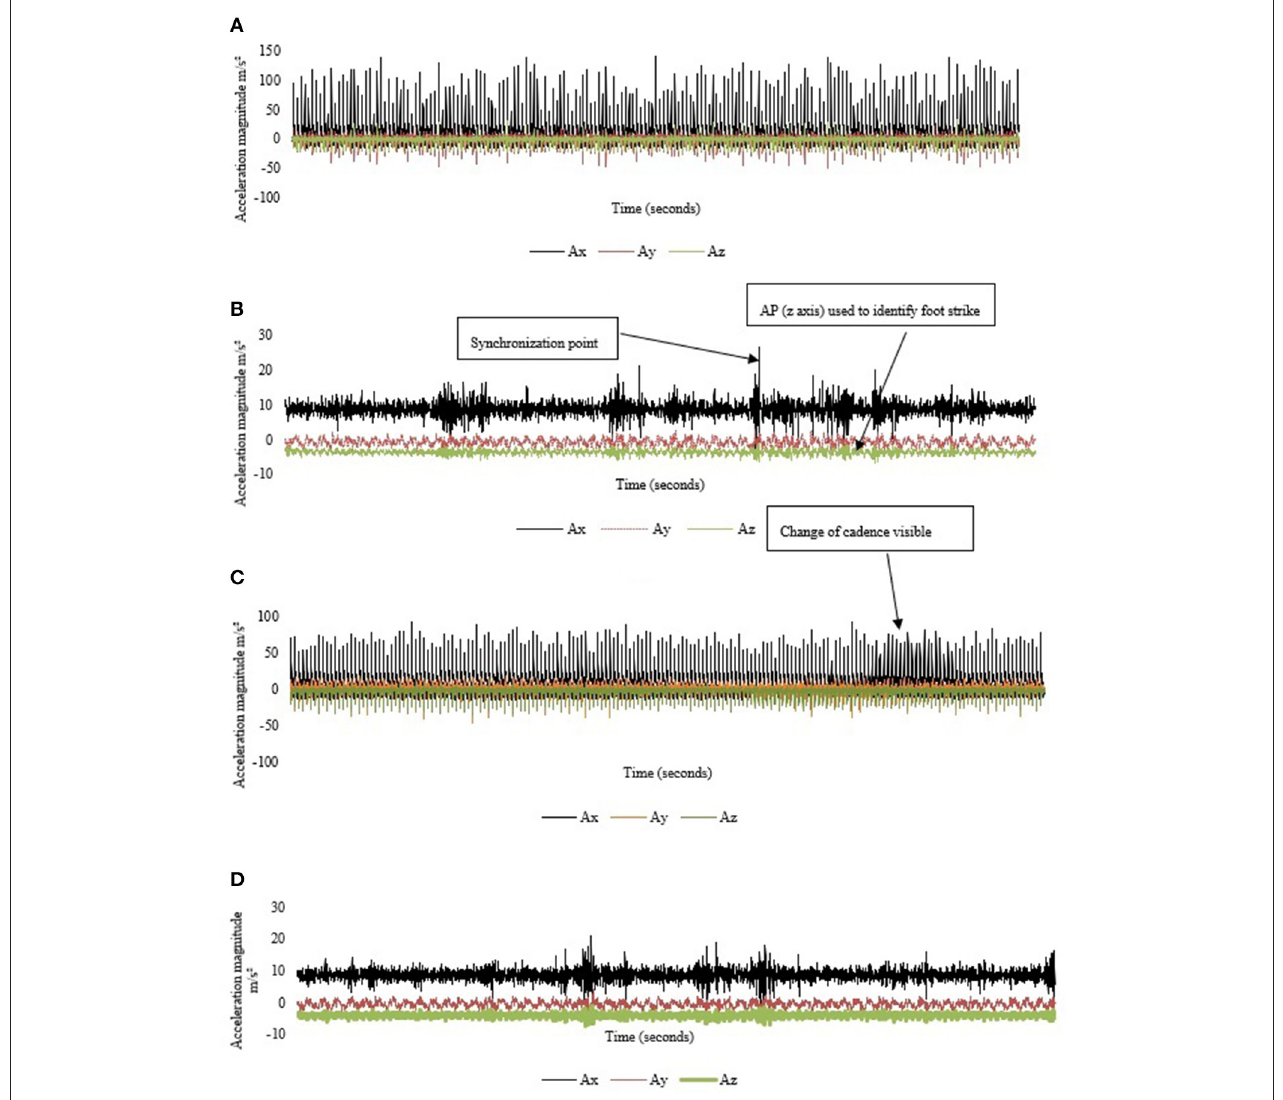
FIGURE 4 | Example of raw signal vector magnitude of CoM acceleration during 60s for one participant in (A) Cycle Drop ; (B) Run Drop ; (C) Cycle Aero ; and (D) Run Aero . Where Ax is CoM longitudinal, Ay is CoM mediolateral and Az is CoM anteroposterior.